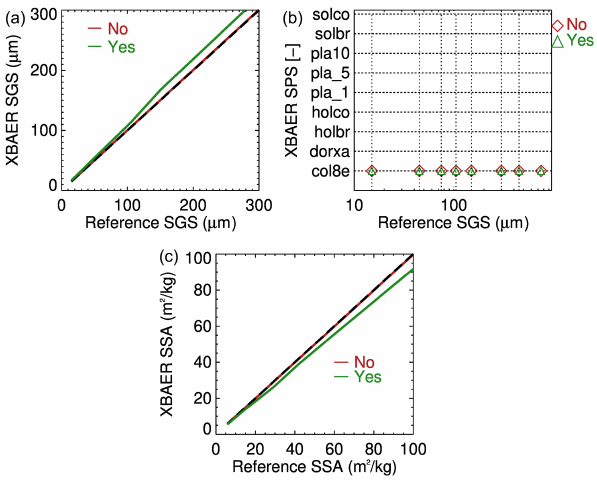
Figure 13. Impact of SRF on the retrieval of SGS (a) , SPS (b) and SSA (c) . Different colors indicate retrieval results without (No) and with (Yes) the SRF in forward simulations; dashed black line is the 1 : 1